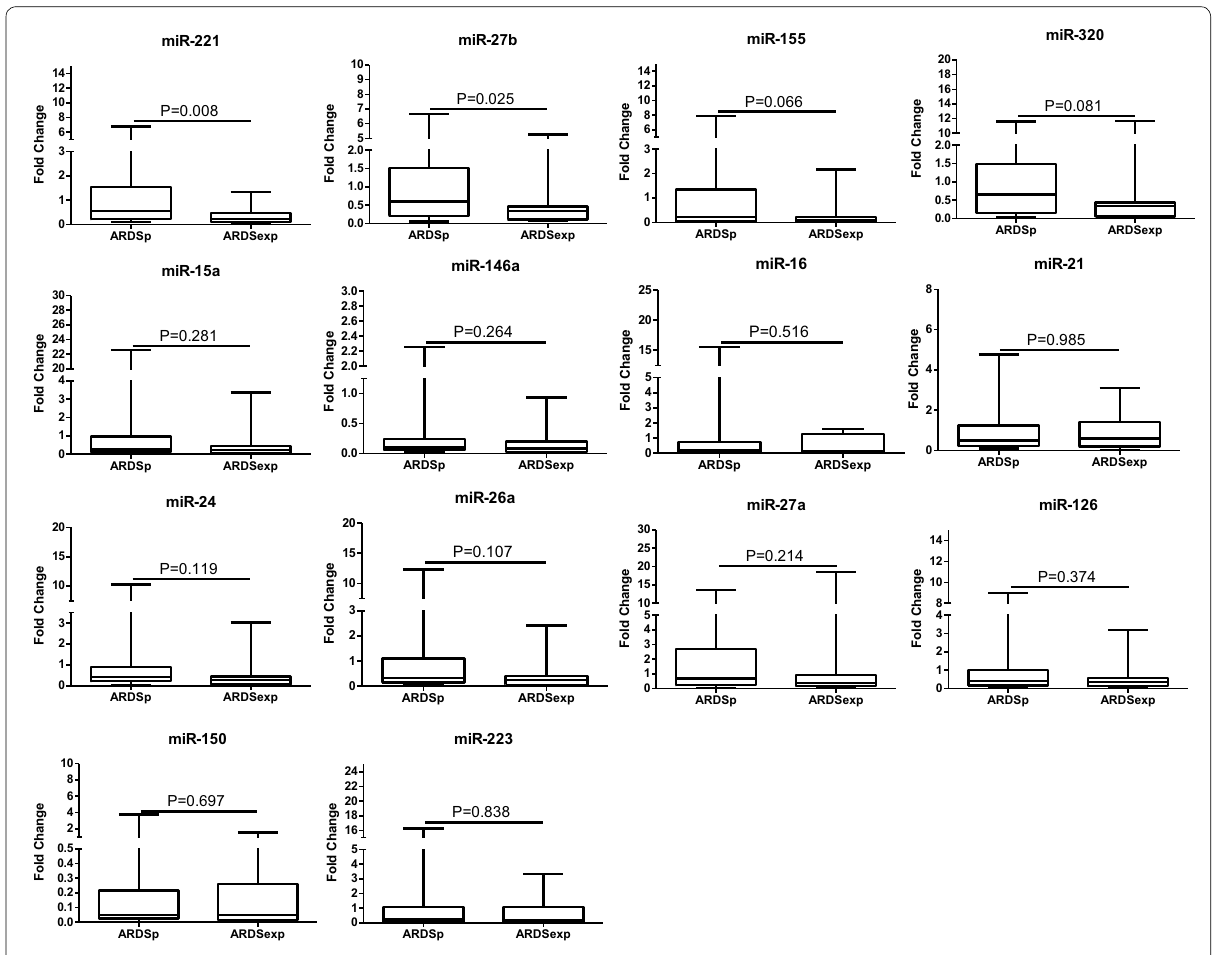
Fig. 1 Comparison of MSC ‑ VEC ‑miRNAs between ARDSp and ARDSexp. Data presented as a relative fold change between ARDSp and ARDSexp for each miRNA. Box plots are displayed where the horizontal bar represents the median, the box represents the IQR, and the whiskers represent the maximum and minimum values. Comparisons made by Mann–Whitney U test. miRNA microRNA, IQR interquartile